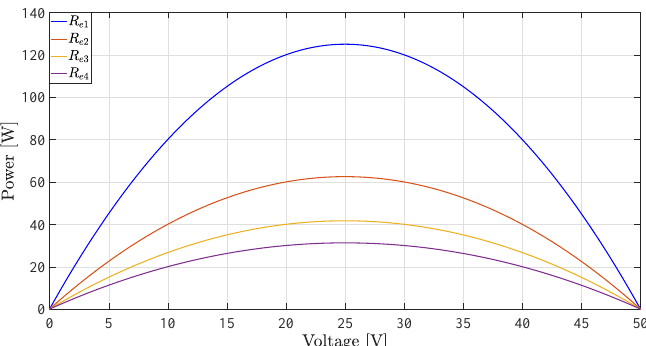
Figure 4. The P-V characteristics of the PV emulator at different power levels.